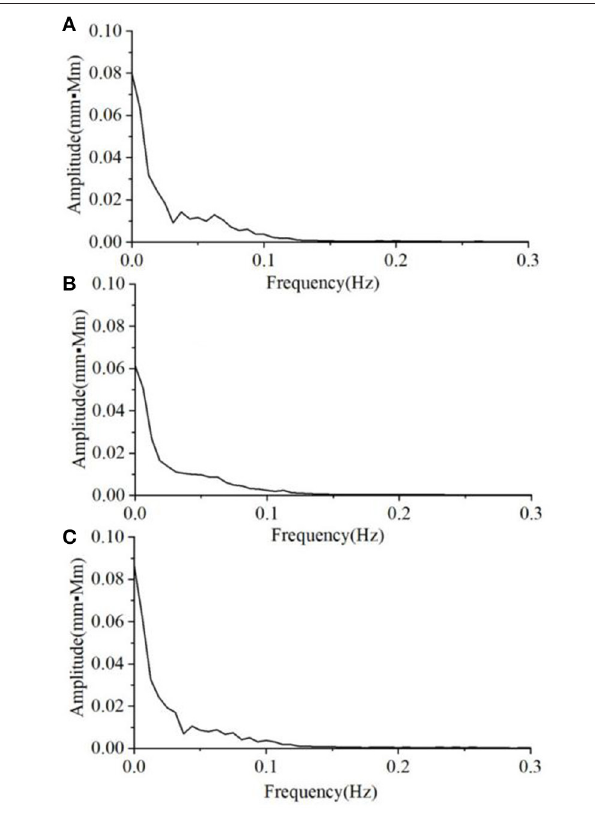
FIGURE 3 | The average magnitude spectrum of the Oxy time-course curves during non-task, in the three groups, i.e. (A) HC, (B) MD, and (C) A&D. Note that the magnitude is almost zero at the range of 0.3–16.0Hz and not shown in the figure.